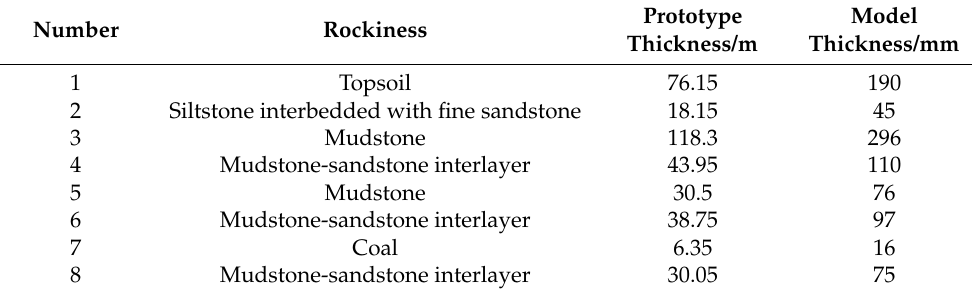
Table 7. Distribution of similar material model rock formations.